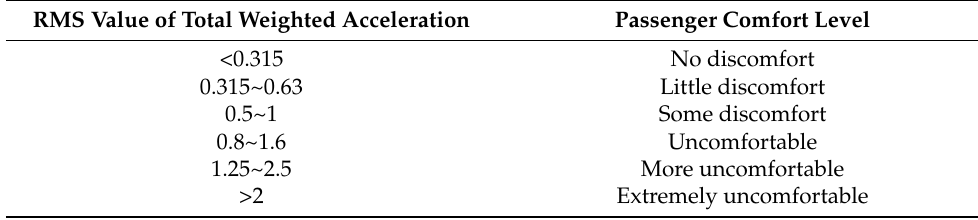
) , d d x y L5 Figure 14. Scenario model in cosimulation.